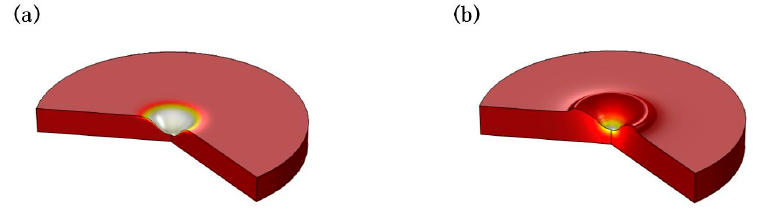
Figure 8. The simulation results of ablation morphology ( a ) the ns spot is larger ( b ) the ms spot is